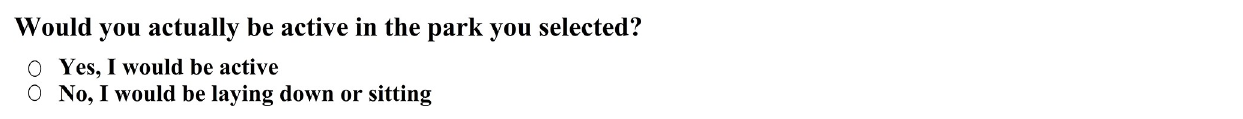
Fig 1. Example of choice task in the second set of choice